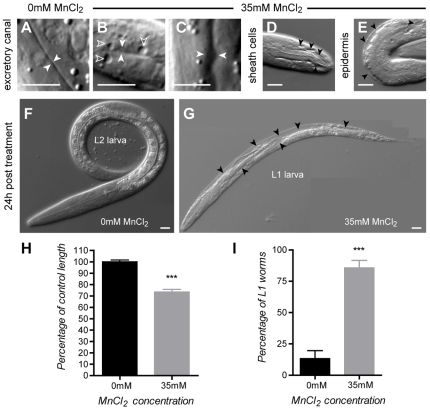
Mn exposure leads to severe osmoregulation defects and developmental delay.(A) Excretory canal in a control wild type L1 larva (solid white arrow heads). (B, C) Enlargement of the excretory canal in L1 larvae acutely exposed to 35 mM MnCl2, after 24 h (solid white arrowheads) is associated with vacuolization (hollow arrowheads). Vacuoles are also observed in the sheath cells of the chemosensory organs (D) and in the epidermis (E). (F) Control larva 24 h after 0 mM MnCl2 treatment. (G) Dying vacuolated (black arrowheads) larva 24 h after 35 mM MnCl2 exposure. (H) worms exposed to 35 mM MnCl2 (grey) are about 30% shorter than control animals (black). I, most larvae exposed to 35 mM MnCl2 are still in L1 stage at 24 h post-treatment when control animals are L2. Error bars represent SEM, *** p<0.001, scale bars are 5 µm.